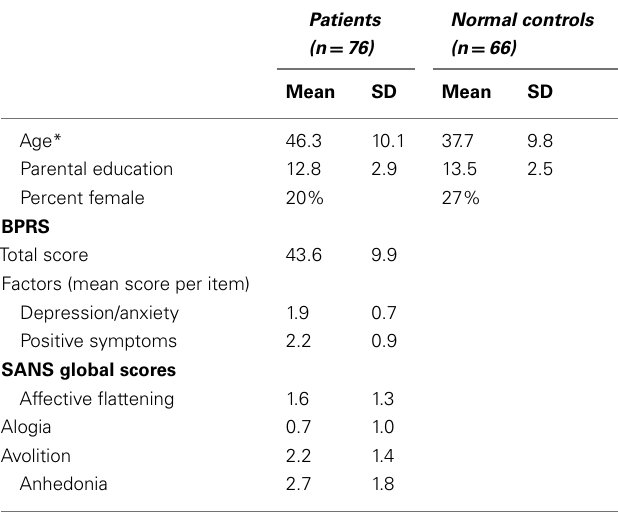
Table 1 | Demographic information and symptom